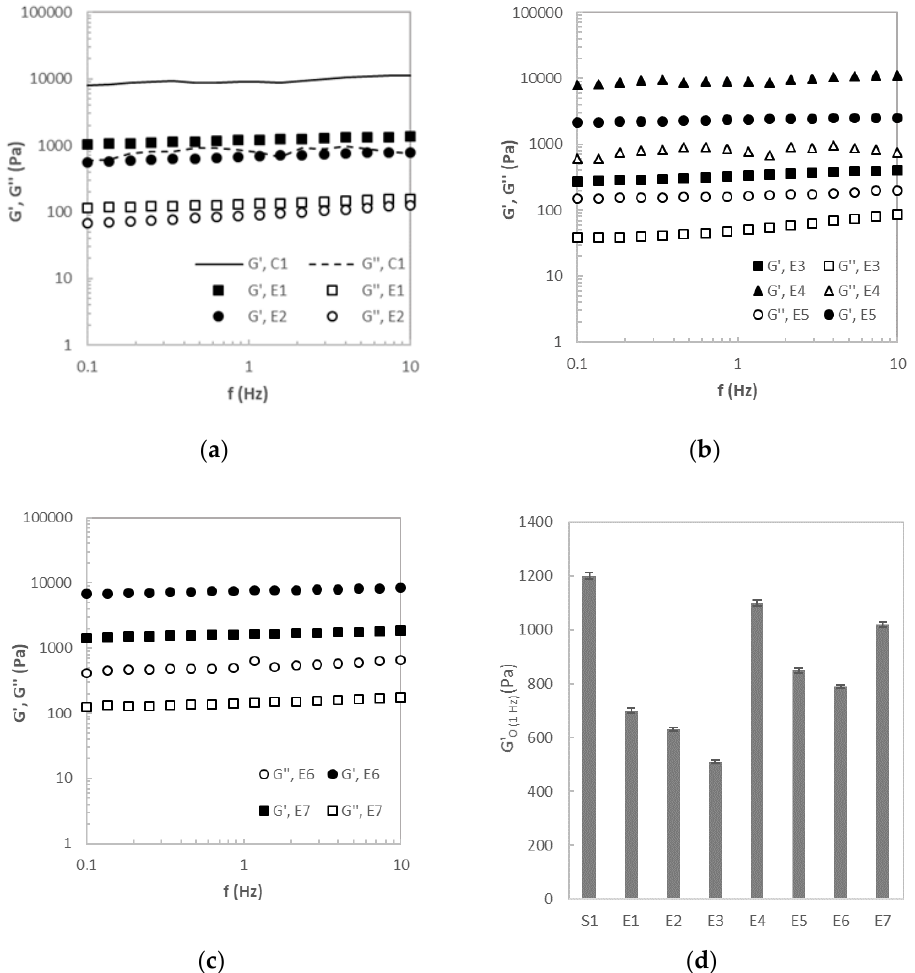
Figure 3. Viscoelastic features of the proposed matrices, prepared with ( a – c ) hybrid carrageenan or ( d ) potato starch in the presence of extract from Camellia sinensis agricultural wastes and industrial hops (see Table 1 for coding). Note here that C1 and S1 are the controls prepared with hybrid carrageenan and potato starch, respectively.